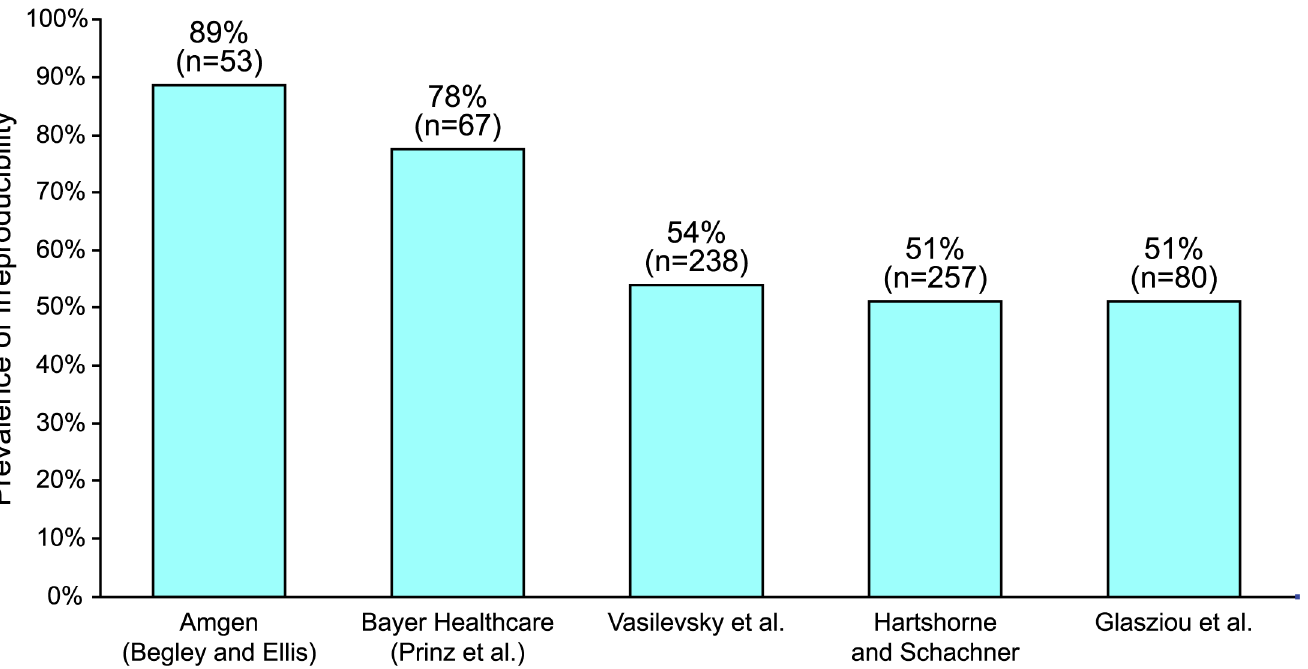
Fig 1. Studies reporting the prevalence of irreproducibility. Source: Begley and Ellis [6], Prinz et al. [7], Vasilevsky [8], Hartshorne and Schachner [5], and Glasziou et al. [9].